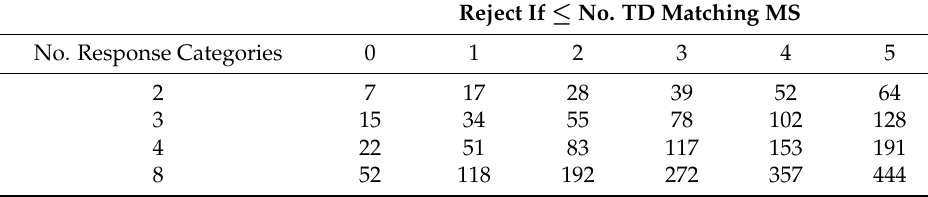
Table 1. Smallest sample size needed to reject a condition value at the 5% level based on a categorical response, such as when estimating succession interval from insect presence/absence or estimating insect age from life stage. For example, a succession pattern of a single species would have two response categories: present or absent on each training data (TD) experimental corpse at a given time since placement. If the number of TD corpses was 7–17, a time since death is rejected if zero TD corpses match the mystery specimen (MS, a corpse with a known set of insect species but unknown postmortem interval (PMI)). With 17–27 TD corpses, a time since death is rejected if zero or one TD corpse matches the MS, etc. Non-rejected values constitute a 95% confidence set on succession interval